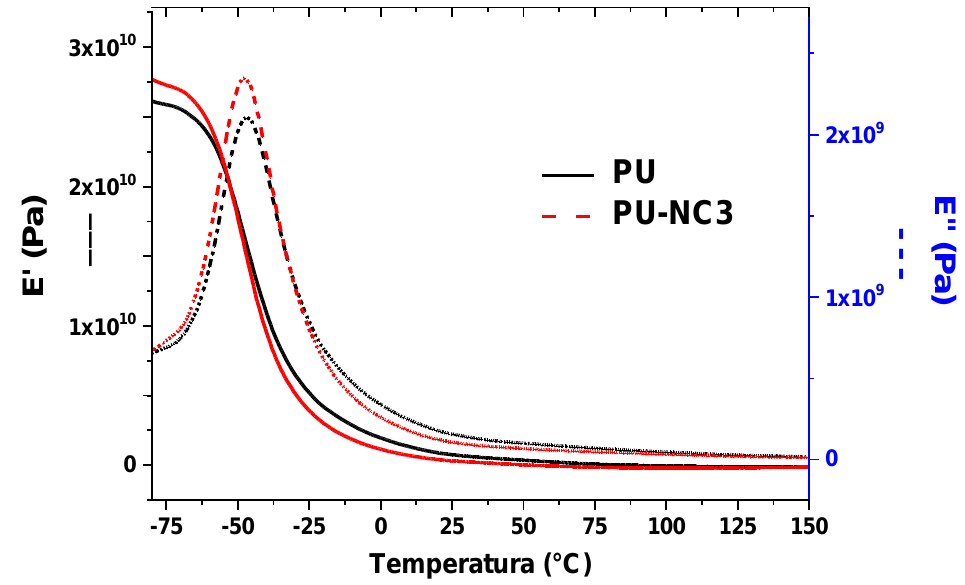
Figure 9. Comparative E (cid:48) and E” plot between polyurea and polyurea-polyurethane nanocomposites. Both E (cid:48) and E” were higher in the case of PU-NC3, showing that this nanocomposite possesses the ability to store a significant amount of energy, and it can also dissipate a higher quantity of energy in comparison with the neat polyurea (PU). The peaks corre- sponding to the loss modulus can allow the estimation of the glass transition temperature at around − 50 ◦ C, indicating that this value obtained through DMA technique is following DSC